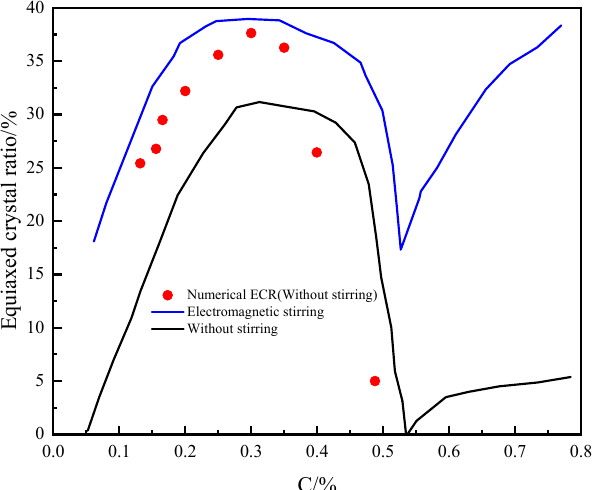
Figure 13. Comparison of simulation results and calculation curves showing the effect of C content on the slab ECR.